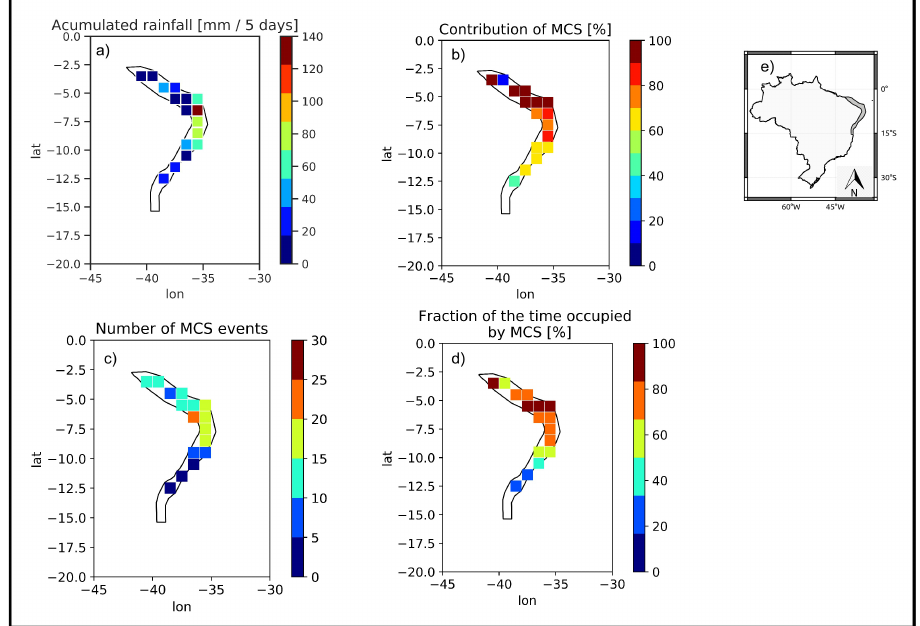
Figure 16. ( a ) Accumulated rainfall recorded during 14 April 2016 to 18 April 2016 over northeast coast of Brazil (R4); ( b ) fraction of rain on days that had MCS records over the rain accumulated in five days; ( c ) number of MCS events recorded in five days; ( d ) fraction of the days that had MCS records; ( e ) analyzed